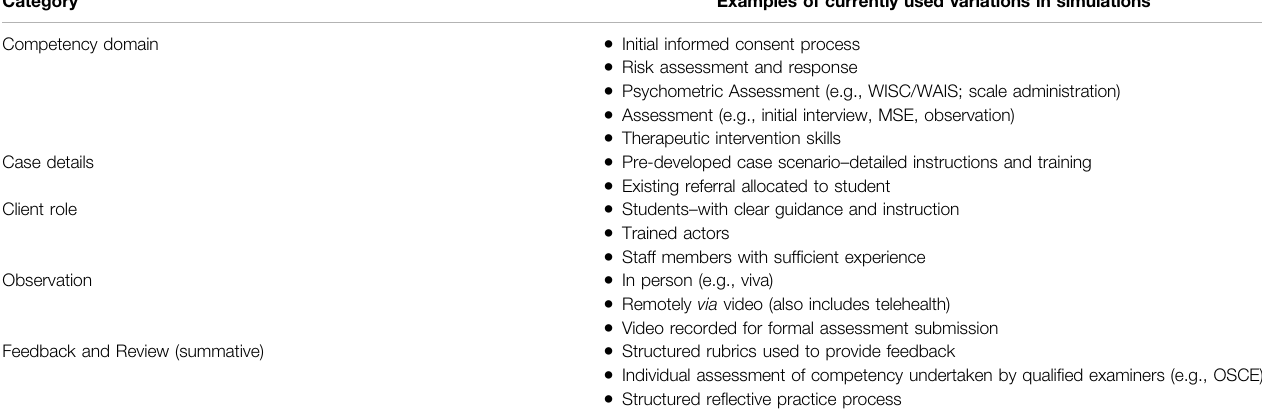
TABLE 5 | A summary of methods for competency demonstrations. Category Examples of currently used variations in simulations Competency